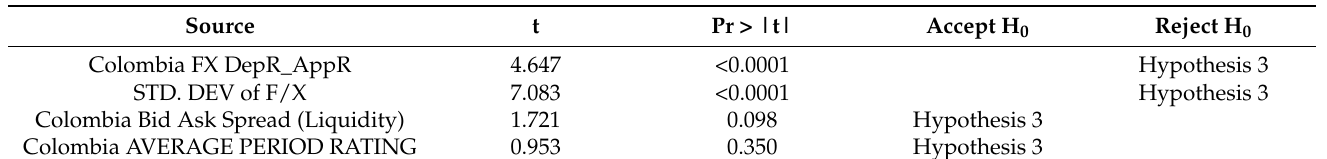
Table 8. Model parameters for Colombia.